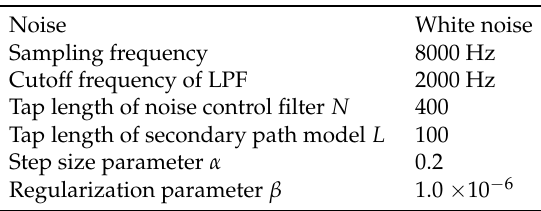
Table 4. Simulation conditions for experiment 2.